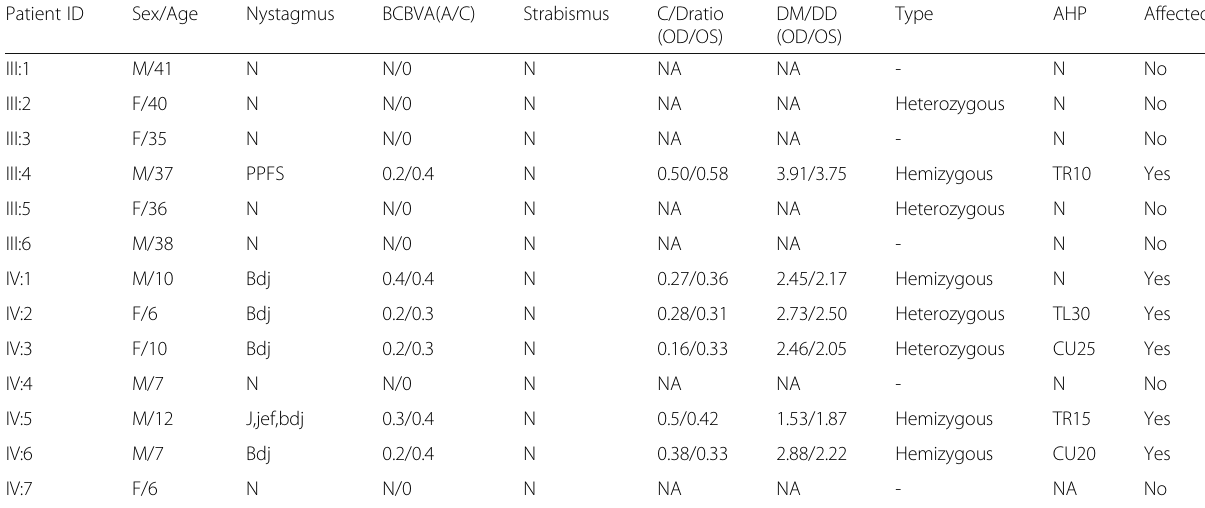
Table 1 Genotypes and phenotypes of this Chinese